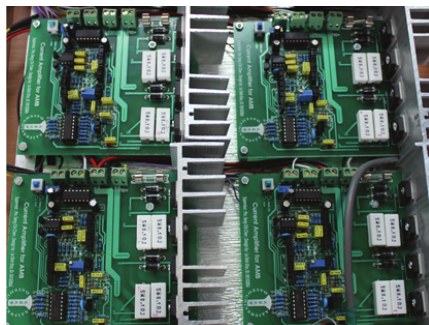
Figure 16: Photograph of current amplifier and current sensing.